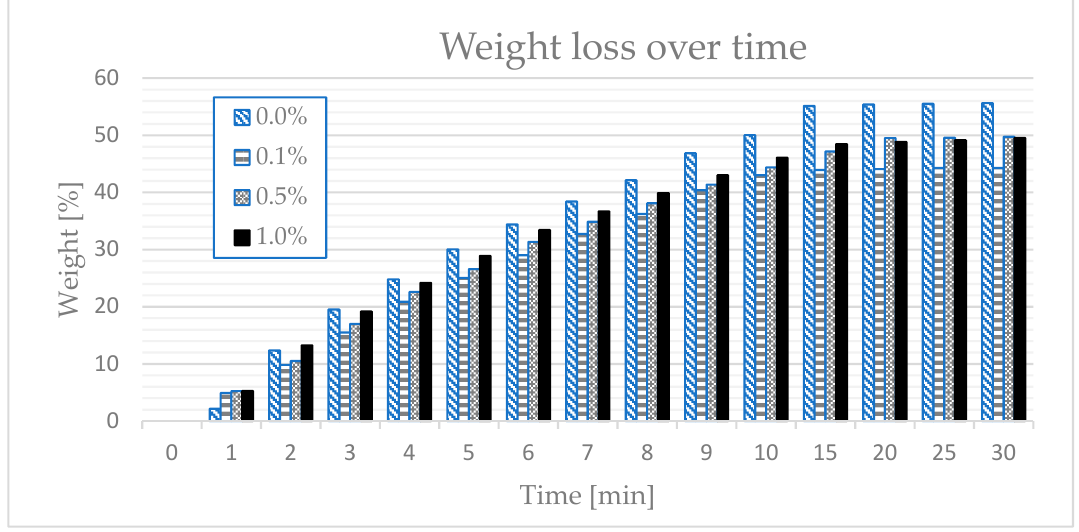
Figure 2. Results of the paraffin rising test.